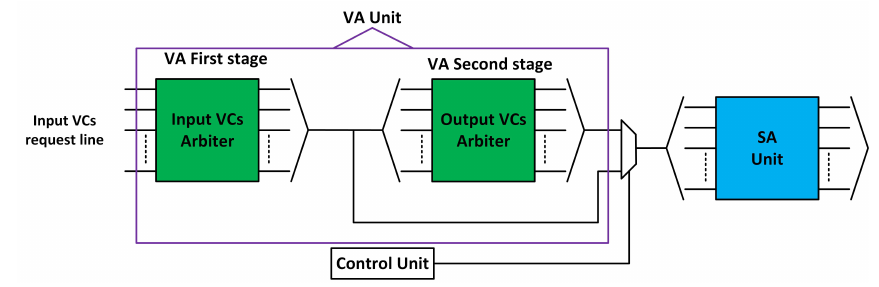
Figure 7. VA2 fault-tolerant